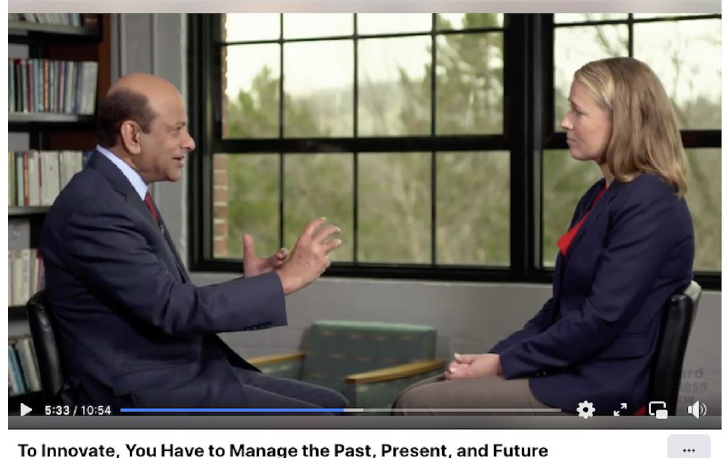
Figure 2. Interaction between researcher and interviewer in T2.